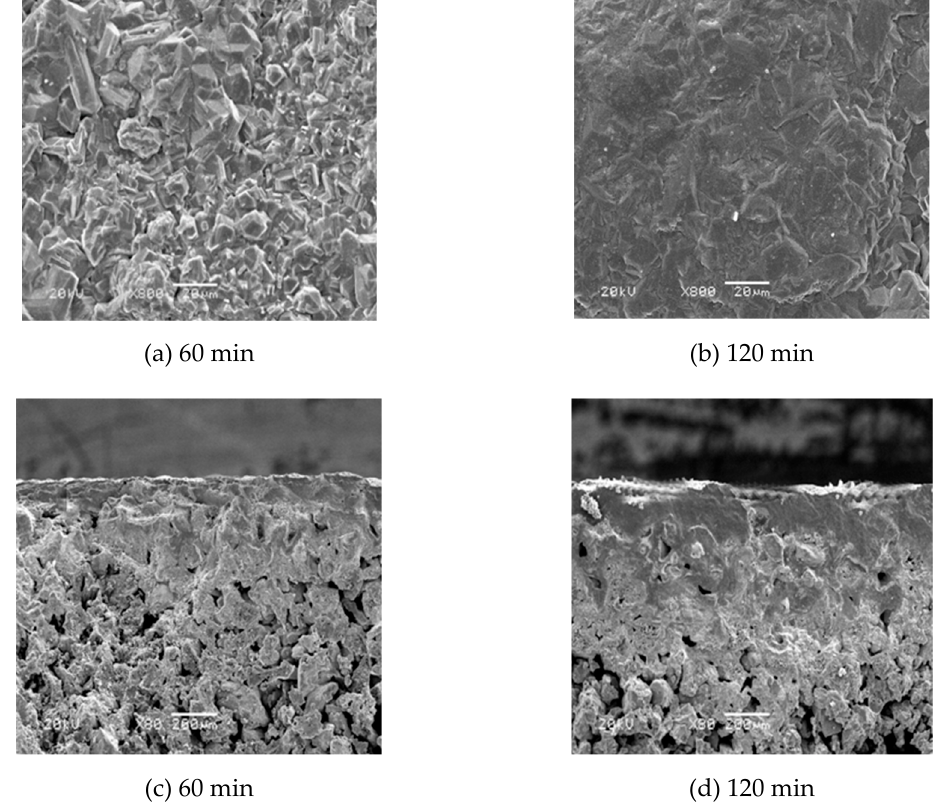
Figure 10. The surface and cross-section of Ti support after oxidation at different times (800 °C, N 2 : O 2 = 2:1).